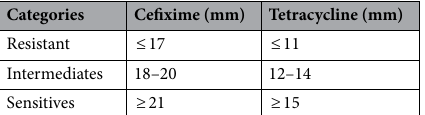
Table 1. Categories of cefixime and tetracycline inhibition zone